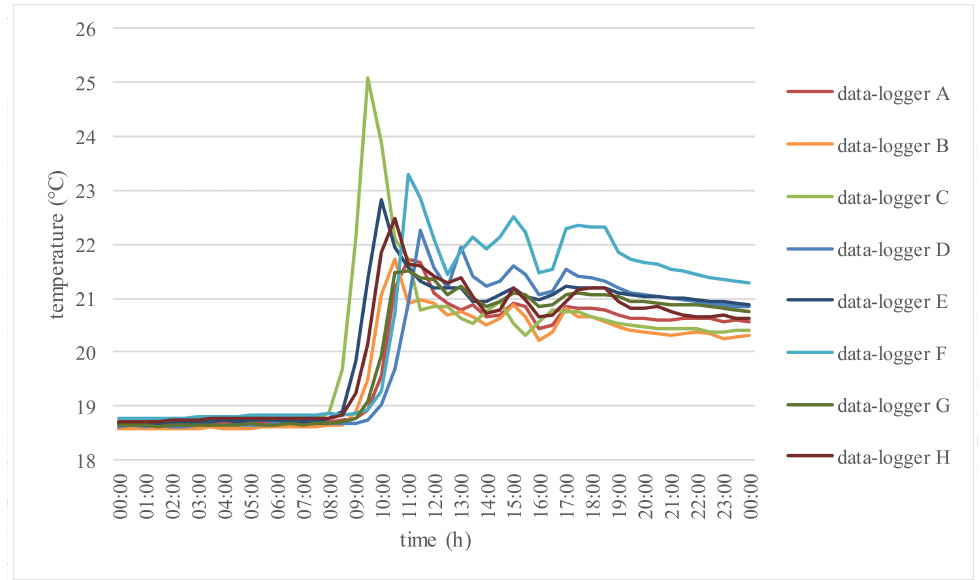
Figure 5. Indoor air temperature detected by the temperature probes during the day before the treatment (23 April 2014).